Question: What does this figure show? Answer in one sentence.
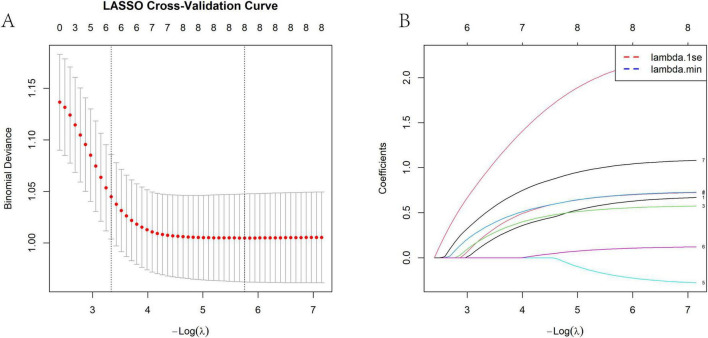
Answer: LASSO regression analysis result chart. (A) LASSO regression cross validation plot. (B) LASSO regression coefficient path diagram.